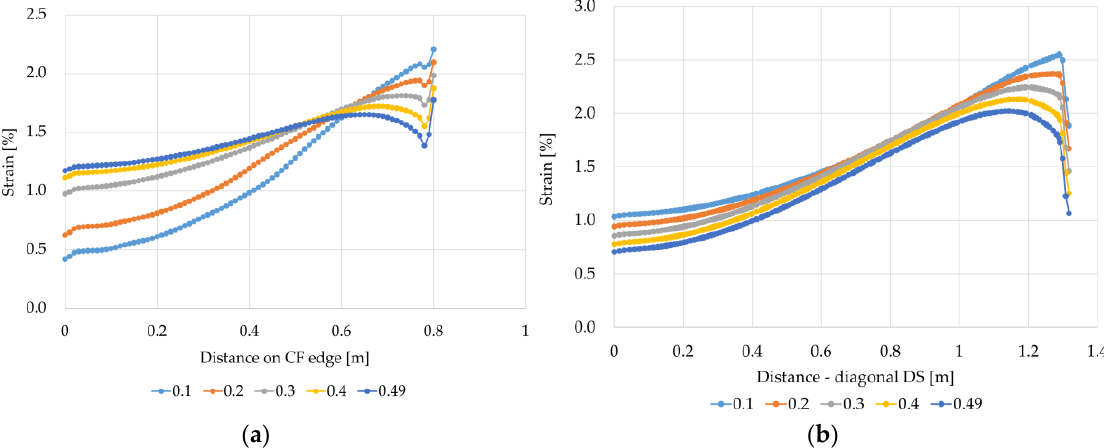
Figure 19. Graphs of membrane strains depending on the Poisson’s ratio value—variant B2: ( a ) on the edge CF; ( b ) on the diagonal DS.